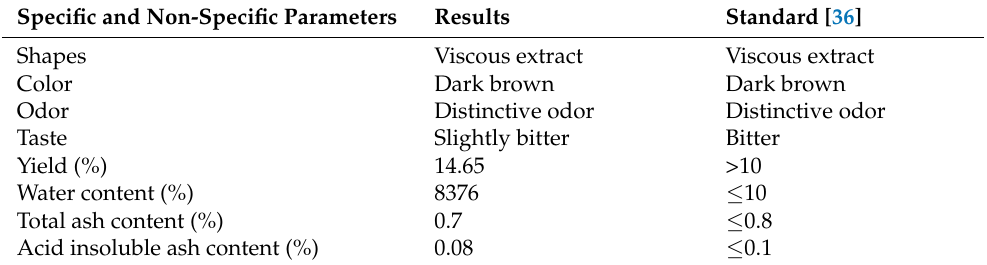
Table 1. The results of standardization of Noni fruit extract.